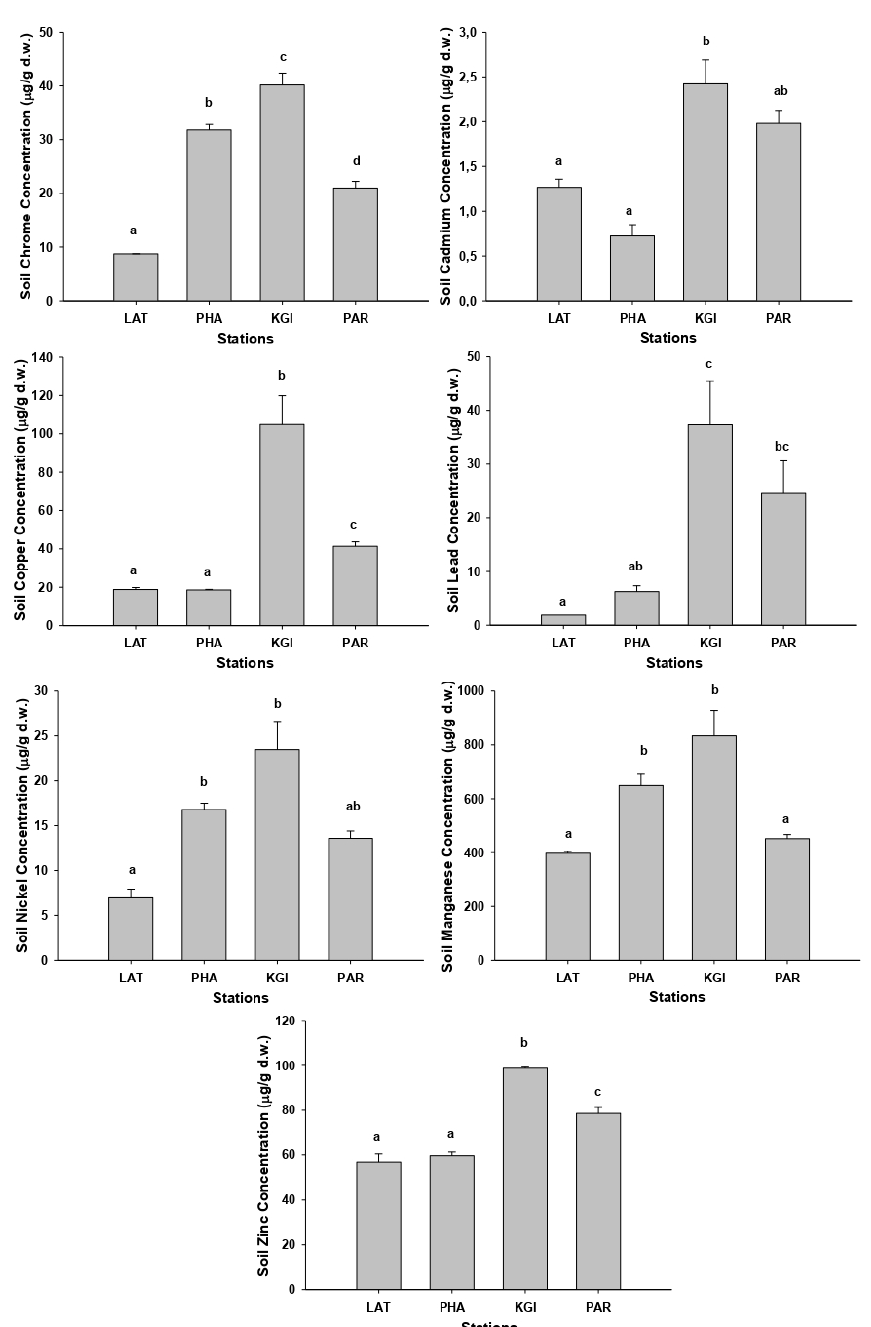
Figure 1. Graphic representation of the concentrations ( µ g/g dry weight) of Cd, Cu, Cr, Mn, Ni, Pb, and Zn in the soils of the species Colobanthus quitensis collected at the stations Lagotellerie Island (LAT), Hannah Point Peninsula (PHA), King George Island (KGI), and Punta Arenas (PAR). Different letters indicated statistical differences ( p < 0.05).